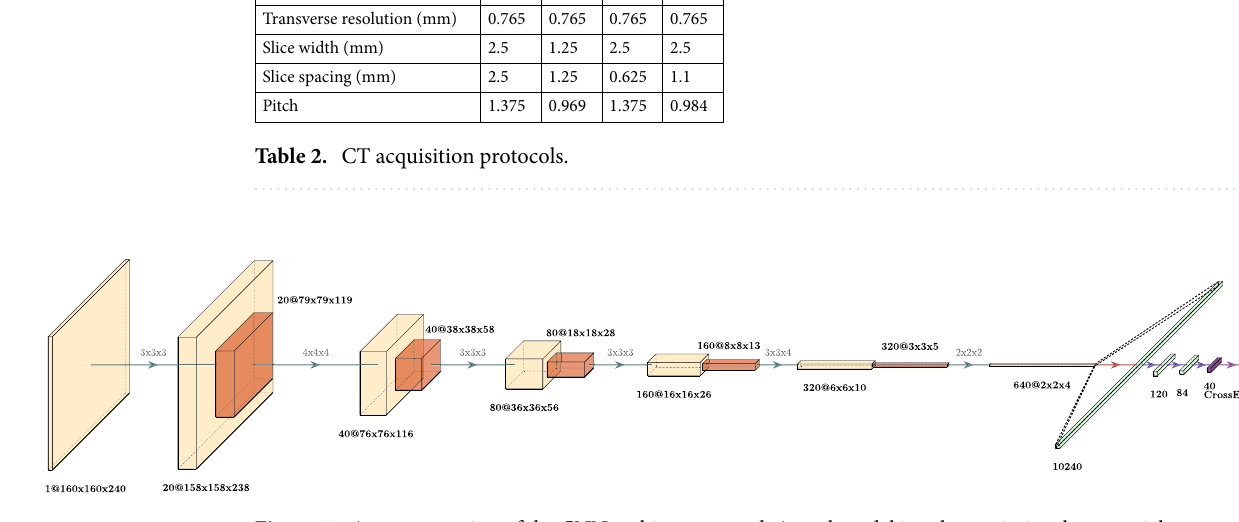
Figure 4. A representation of the CNN architecture used. Actual model is volumetric, i.e. three spatial dimensions plus a channels dimension. Green arrows represent convolution operations with stride of 1. A ReLU nonlinear activation is applied after convolutions, and then a 2×2×2 max pooling in order to reduce spatial dimensions. Red arrow represents flattening. Blue arrows are full connections (with a 0.25 dropout), purple arrow stands for the final classifier with Log SoftMax and Cross Entropy loss